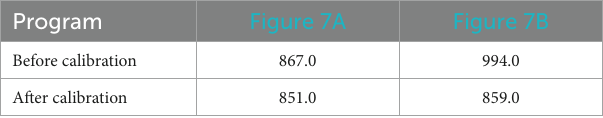
TABLE 3 Cell count results of patch with white area (Figure 7A) and patch only contains tissues (Figure 7B).